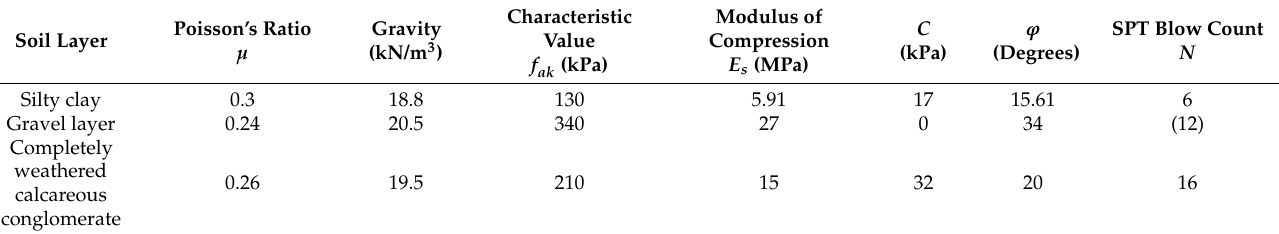
Figure 2. Typical geological profile of 9# building. Table 2. Physical and mechanical parameters of soils.